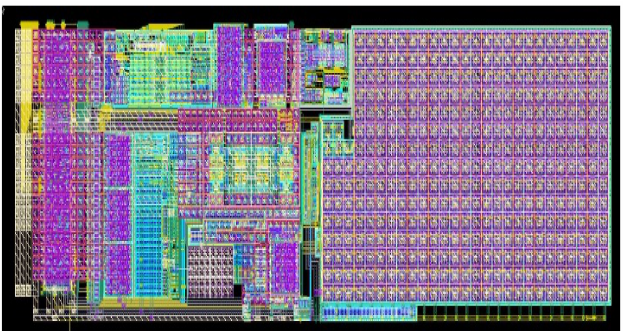
Figure 18. PLL layout (379.765 × 1325.115 µ m).